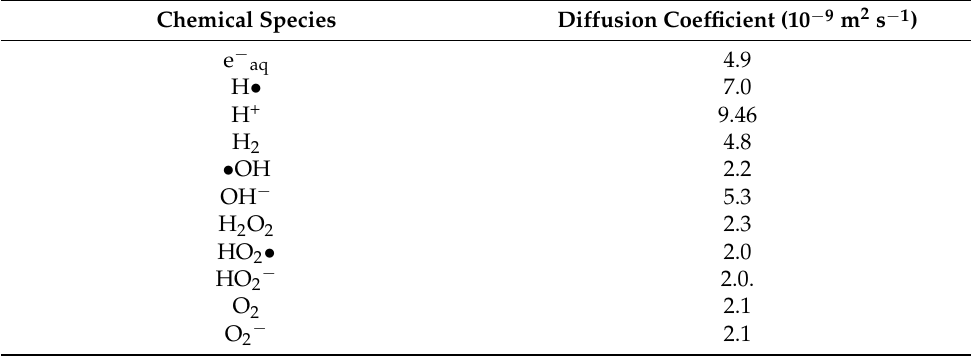
Table 7. Diffusion coefficients used in the simulations